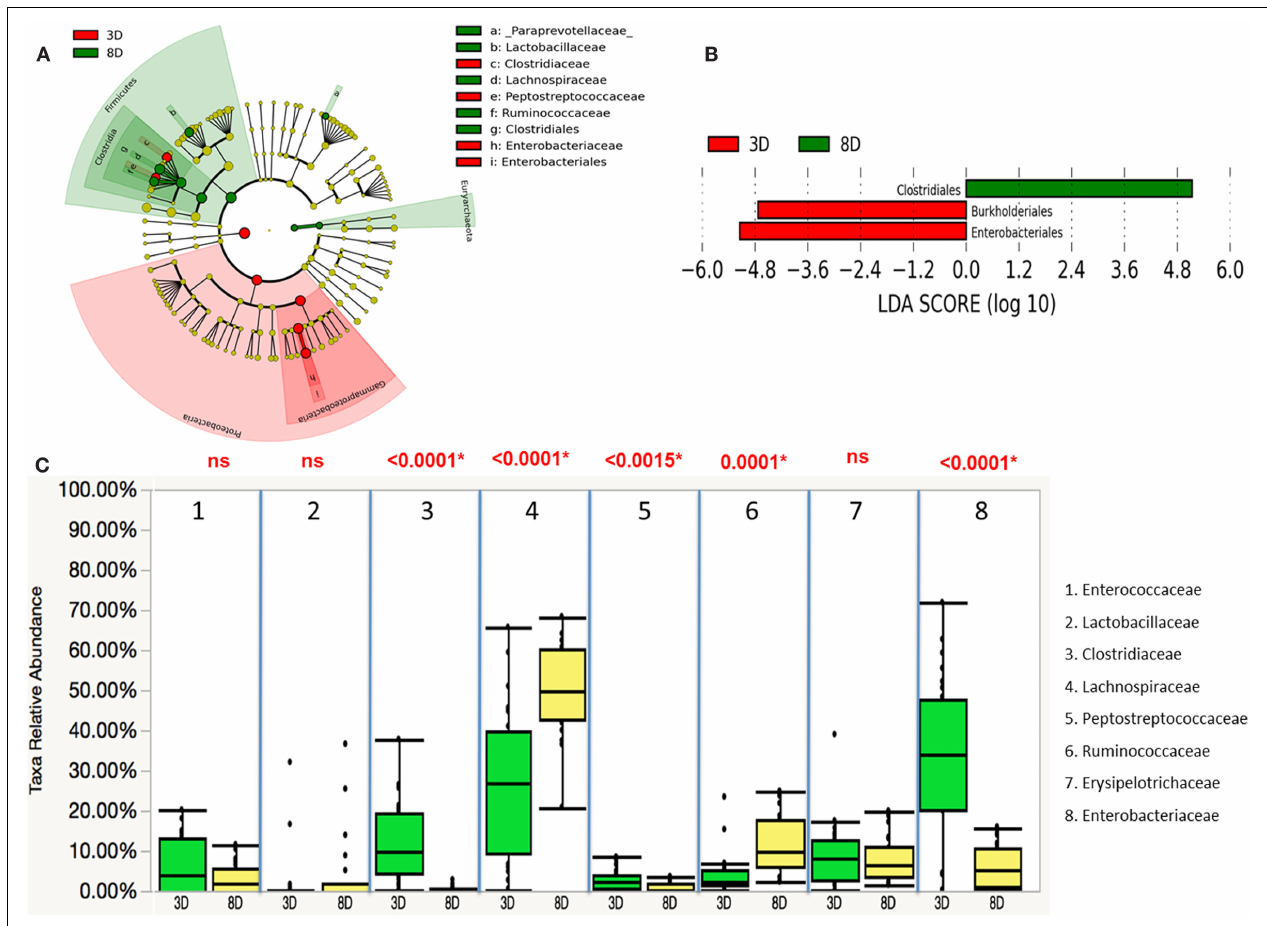
FIGURE 3 | Differential abundances of cecal microbial communities between two age groups . (A) Taxonomic cladogram generated from LefSe analysis showing significant difference in microbiota profile of two age groups, red represented the enriched taxa in 3days olds’ microbial community and green represented the enriched taxa in 8days olds’ microbial community. (B) Differently abundant taxa detected with cut-off value of linear discriminant analysis (LDA) score > 2.0. Enriched taxa in 8-days-old chicks (green) were indicated with positive LDA score, while taxa enriched in 3-days-old chicks (red) have negative LDA score. (C) Comparison of relative abundance levels of cecal microbiota at family level in 3 and 8days old chicks was evaluated. The boxplot shows the quartiles above and below the median with dark line at center of the box denoting median, black dots showing the outlier. The respective p value for each family group is reported using Wilcoxon rank sum test. Abbreviations: 3D, 3days old; 8D, 8days